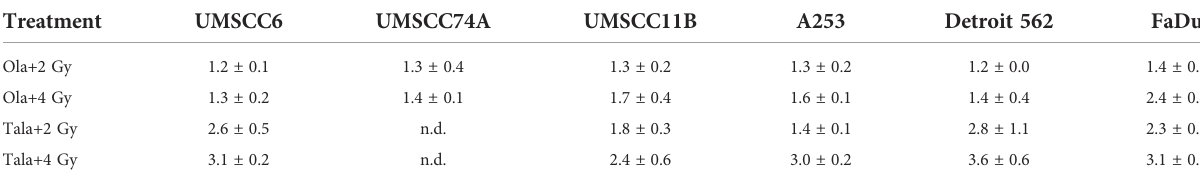
TABLE 3 Olaparib and talazoparib selectively enhance the sensitivity of HPV-negative HNSCC spheroids in response to proton irradiation.